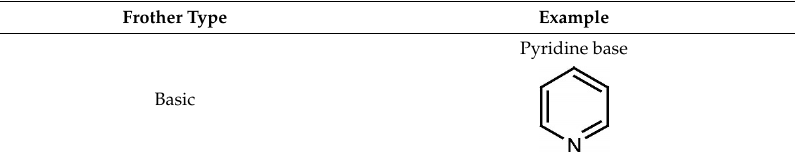
Table 6. Another is the cloud point below which the frother molecules can be dissolved in water. At higher temperature molecules start to associate and solution becomes cloudy as a result of phase separation and surface activity loses. The cloud point is observed for frothers containing polyoxyethylene groups in their structure. Table 7 presents the cloud point for selected